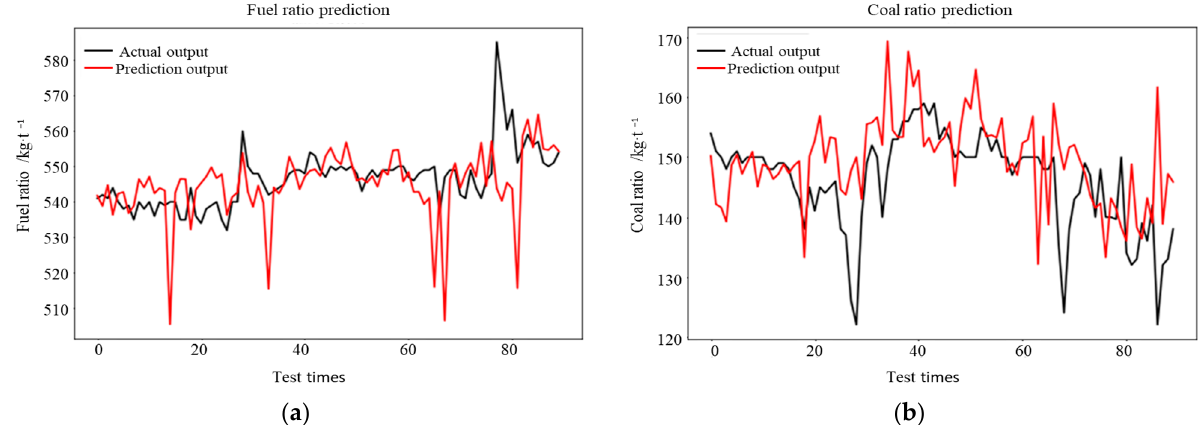
Figure 2. FR and PCR correlation model: ( a ) comparison between the model prediction and actual FR and ( b ) comparison between the model prediction and actual PCR.